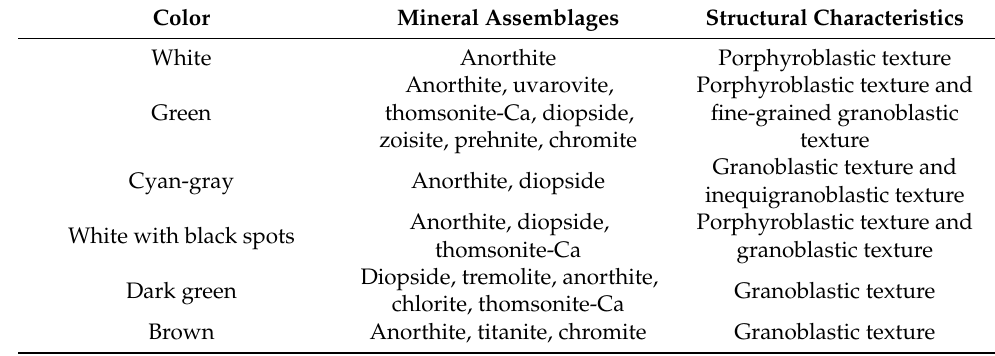
Table 8. The mineral assemblages and structural characteristics of Philippines rock. Color Mineral Assemblages Structural Characteristics White Anorthite Porphyroblastic texture Anorthite, uvarovite, Porphyroblastic texture and Green thomsonite-Ca, diopside, fine-grained granoblastic zoisite, prehnite, chromite texture Granoblastic texture and Cyan-gray Anorthite, diopside inequigranoblastic texture Anorthite, diopside, Porphyroblastic texture and White with black spots thomsonite-Ca granoblastic texture Diopside, tremolite, anorthite, Dark green Granoblastic texture chlorite, thomsonite-Ca Brown Anorthite, titanite, chromite Granoblastic